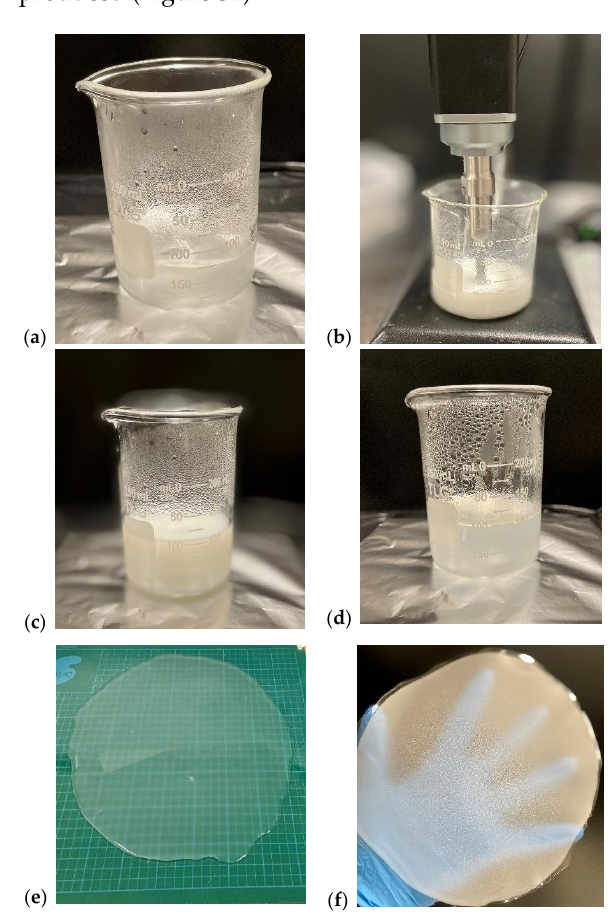
Figure 1. The blend-preparation steps: ( a ) dissolving PVA in DI water, ( b ) mixing starch and nZnO powder, ( c ) adding starch/nZnO and PVA solutions, ( d ) after adding glycerol and citric acid at the interval of 10 min, ( e ) pouring the final solution on the flat glass, ( f ) starch-based polyvinyl alcohol (PVA) blend with inserted nano-zinc-oxide particles (nZnO) . By adding the starch and nZnO solution to the PVA solution and keeping the same stirring speed and the solution temperature, a viscous solution was prepared after 15 min (Figure 1c). Glycerol (2 g) and citric acid (0.5 g) were added to the solution one at a time